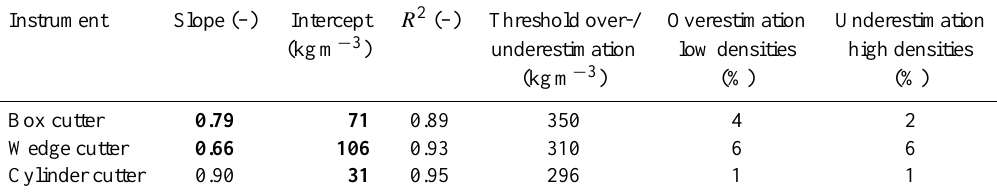
Table 5. Slope, intercept, and R 2 for the linear fit of the cutter densities to the µ CT densities averaged to the resolutions of the respective cutters shown in Fig. 4. Significance ( p val < 0 . 01) for the slope and the intercept is indicated by bold numbers.